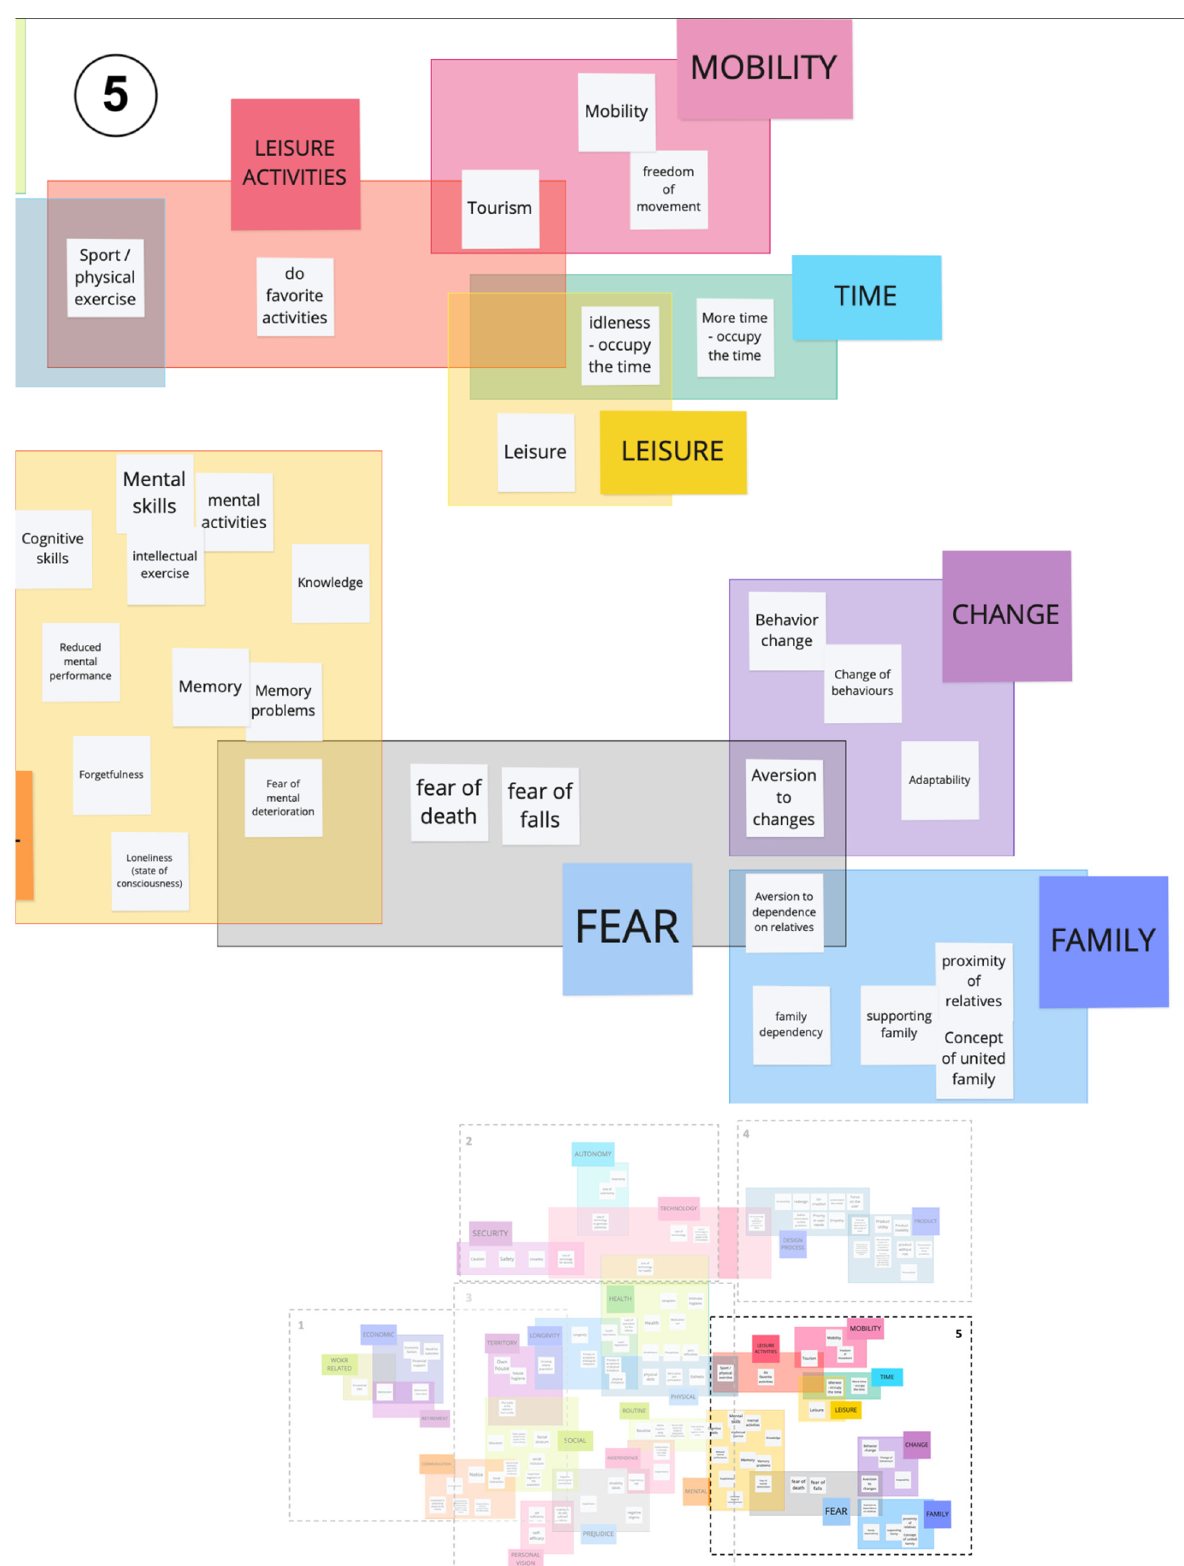
Figure A5. Map Section 5.